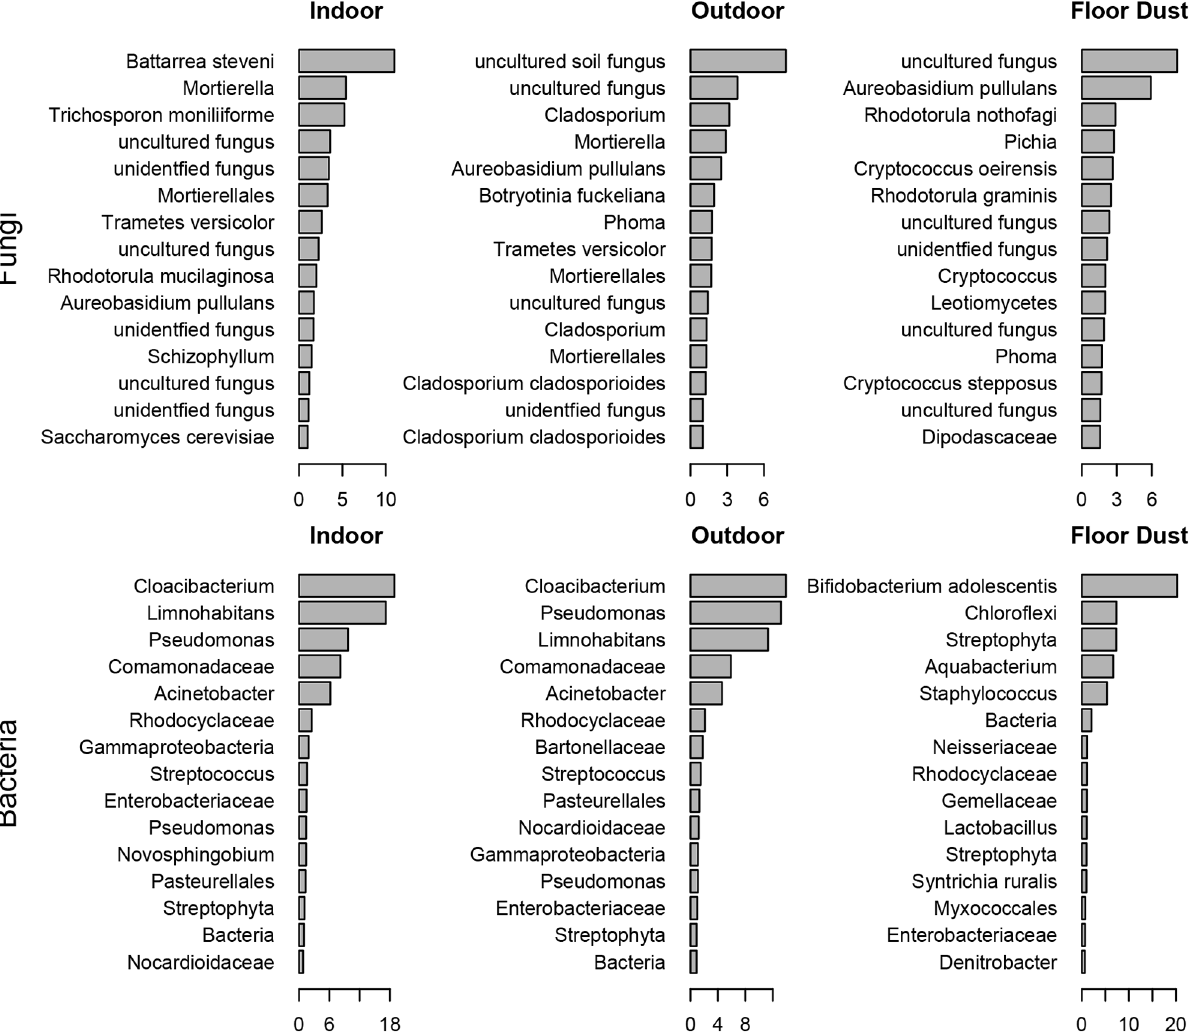
Fig 1. The relative abundance of the 15 most common fungal and bacterial taxa in indoor air, outdoor air, and vacuumed floor dust samples. The x- axis represents the percentage of sequences in each category (indoor, outdoor, vacuum) represented by the top taxa, which were identified to the finest taxonomic level that could be